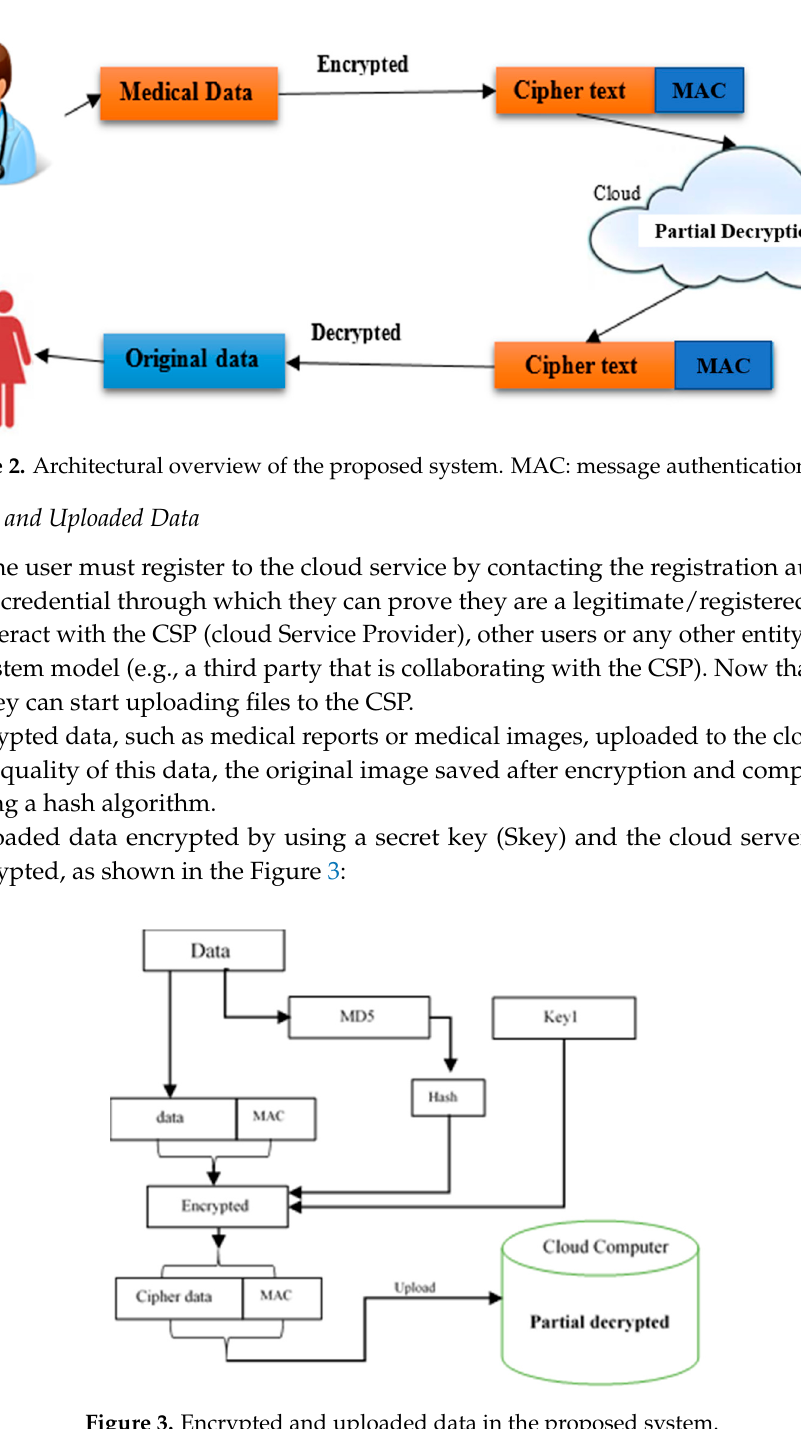
Figure 3. Encrypted and uploaded data in the proposed system.